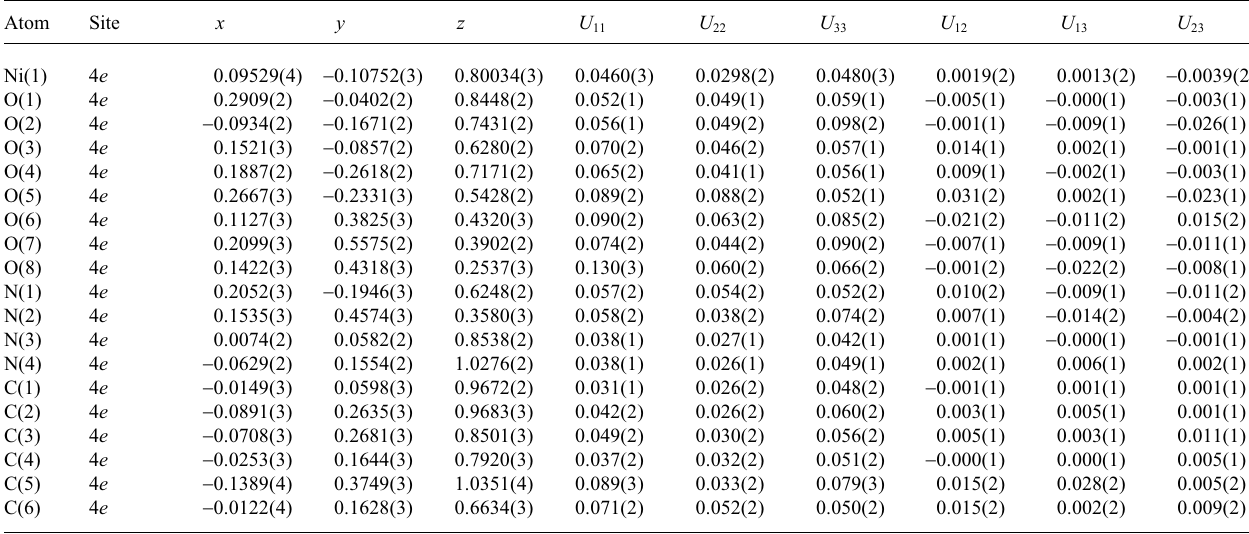
Table 3. Atomic coordinates and displacement parameters (in Å 2 )